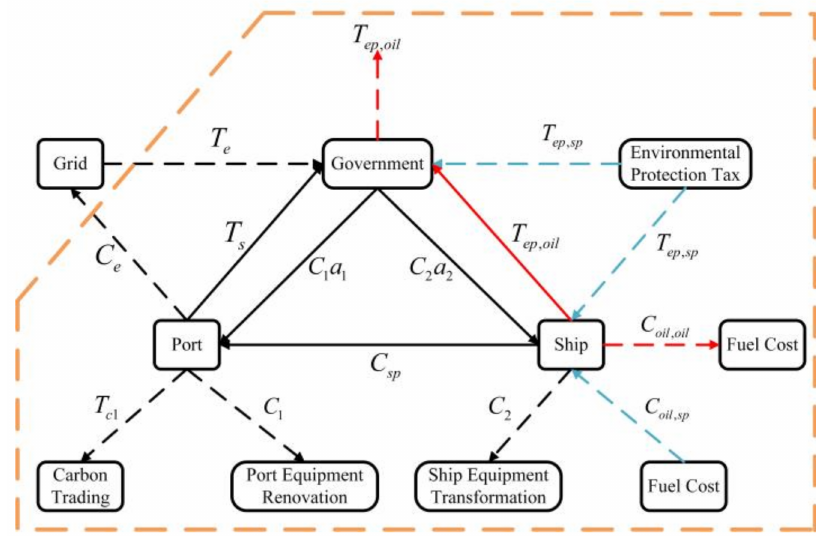
Figure 2. Tripartite benefit analysis under cap and